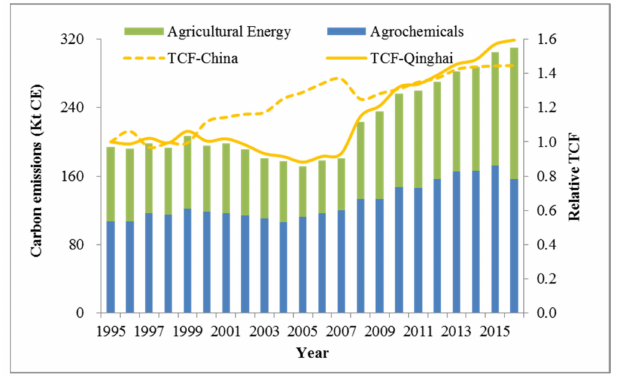
Figure 3. Changing trends of carbon footprints induce by agrochemical and agricultural energy inputs in Qinghai province over 1995–2016. TCF—total carbon